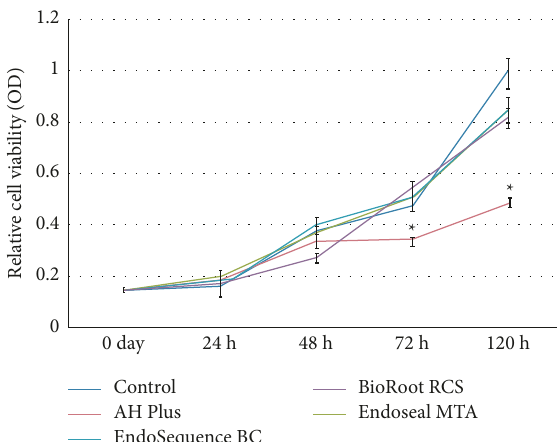
Figure 5: Relative cell viability rate based on the methylthiazolyldiphenyl-tetrazolium (MTT) assay. Statistically remarkable differences among the control and trial groups are shown by asterisks.